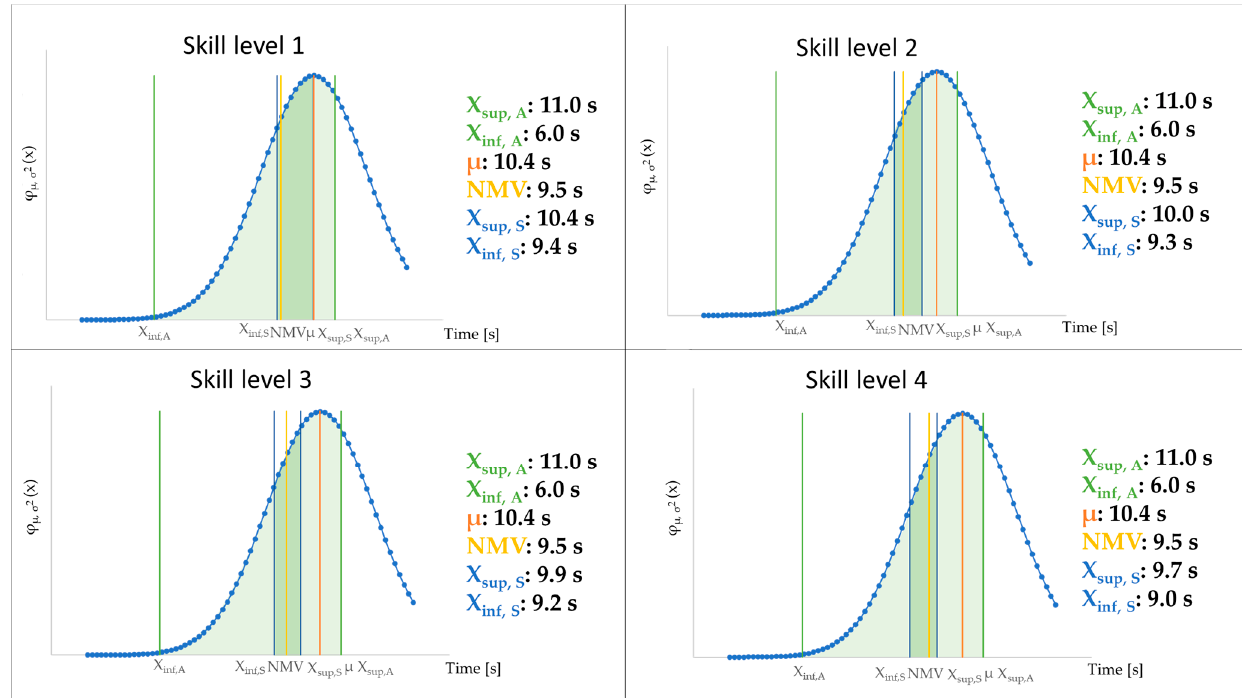
Figure 16. Gaussian distribution of the grasping in workstation B.